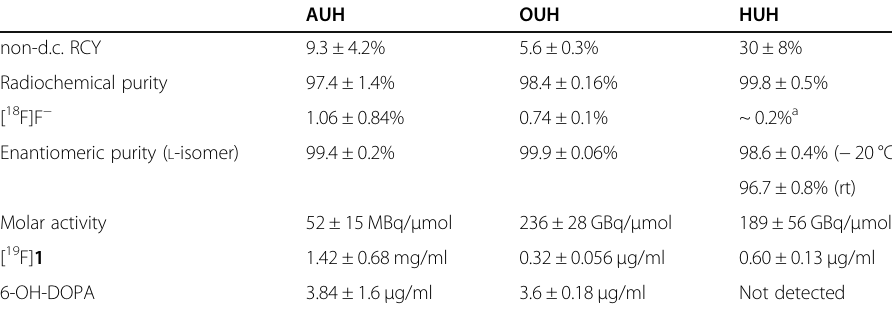
Table 1 Average values of selected production and QC parameters for batches of [ 18 F] 1 produced at the three different productions sites. Errors indicate standard deviations of the mean. The value for the enantiomeric purity at HUH includes productions where the alkylation is carried out at − 20 °C and at room temperature